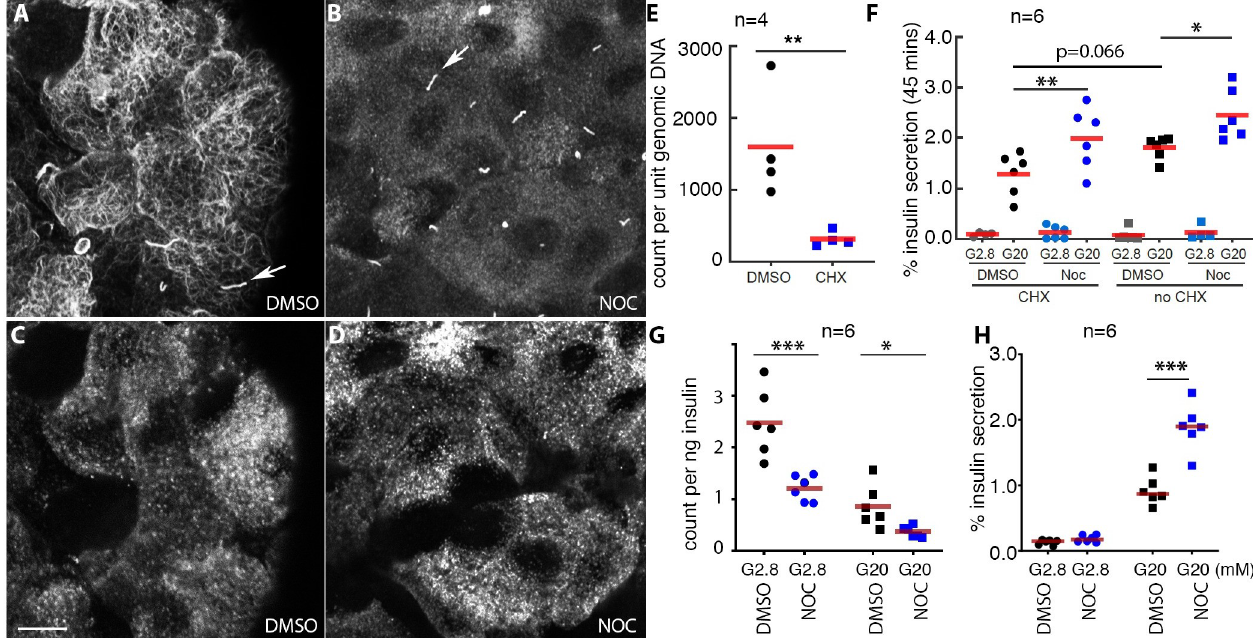
Fig 3. Newly synthesized SGs are dispensable for MT-destabilization-enhanced GSIS. (A—D) Glu-tubulin was stained to verify the effective disruption of MTs by NOC (A, B), with β cells identified by insulin staining (C, D, showing the corresponding fields in A, B, respectively). Arrows in (A, B), primary cilia. Scale bar = 10 μ m. (E) Total radioactive amino acid (3H-Leu/Ile) incorporation after 3-hours CHX-treatment. The radioactivity was normalized against DNA levels, compared via real-time PCR. Also see S1 Fig for uncliped western images. (F) GSIS from islets treated with combination of 10 μ g/ml NOC and 10 μ M CHX. Note that the presence of CHX did not eliminate the NOC-potentiated GSIS (compare columns 2 and 4). (G) The radioactive insulin that were secreted (count/ng insulin) in control and NOC-treated islets, following a 4-hour radiolabeling process. (H) % of total insulin secretion in samples used in panel (G). In (E-H) � : p < 0.05; �� : p < 0.01; ��� : p < 0.001, values from Holm-Sidak’s multiple comparisons (E, G, H) or Turkey’s multiple comparisons (F). The p-values, not shown between low-glucose samples, are all above 0.3. Please refer to S1 Table for original numbers used in plots.